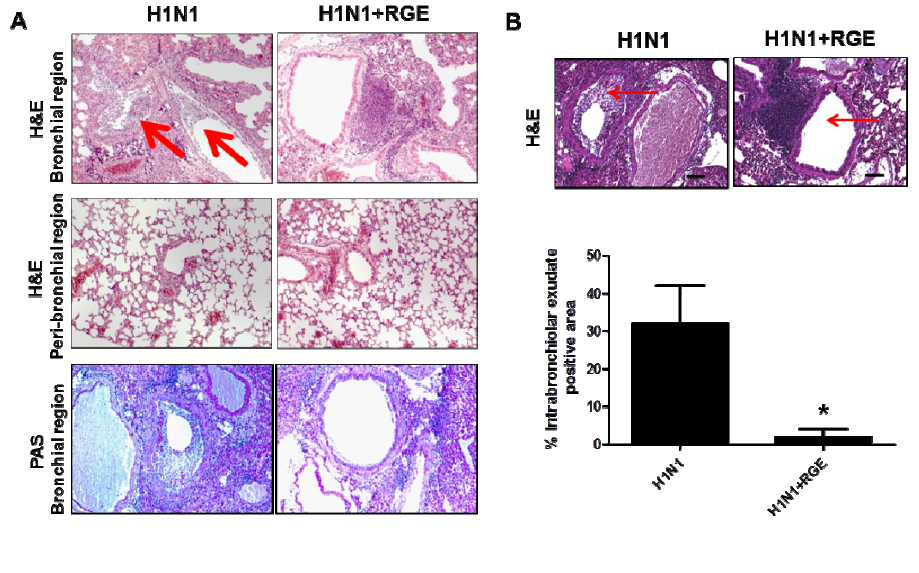
Figure 6. Influence of RGE on pulmonary histopathology in mice infected with H1N1 influenza A virus. ( A ) HE and PAS staining of lung tissues. ( B ) Intrabronchiolar exudates of necrotic cell debris. RGE was administered orally at a dose of 25 mg/kg/day for 30 days and then mice were challenged with H1N1 influenza A virus. Lungs were prepared for tissue sections, as described in Materials and Methods, and stained with H & E or PAS. All images were acquired using the same camera settings. Images were acquired using a Zeiss Axiovert 100 microscope at a magnification of 100×, using an attached Canon 30D digital